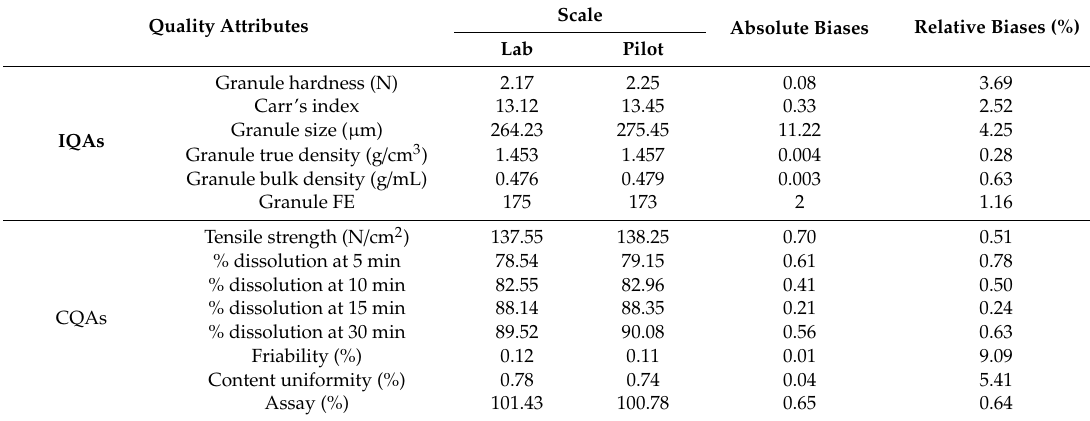
Table 6. Validated results for IQAs and CQAs in the scale